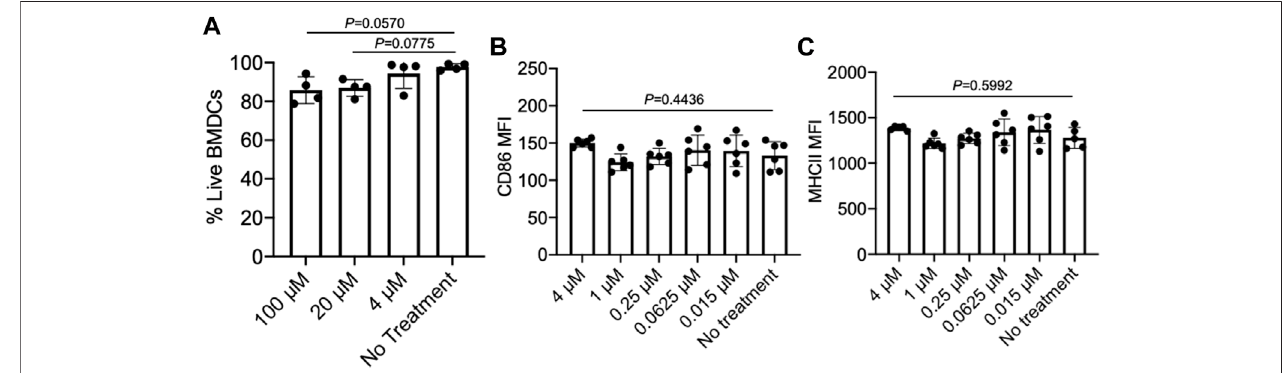
FIGURE4| Epacadostat shows aminimal effect on thesurvivaland activationstatus ofDCs. (A) Viability ofBMDCs after treatment withdifferentconcentrationsof epacadostat for 48 h. (B) CD86 MFI of BMDCs after treatment with different concentrations of epacadostat for 24 h. (C) MHCII MFI of BMDCs after treatment with differentconcentrationsofepacadostat for24 h. All thenumerical dataarepresented asmean±SD(0.01 < * p ≤ 0.05;** p ≤ 0.01; *** p ≤ 0.001). In situ DCrecruitmentof gels loaded with GM-CSF and epacadostat.